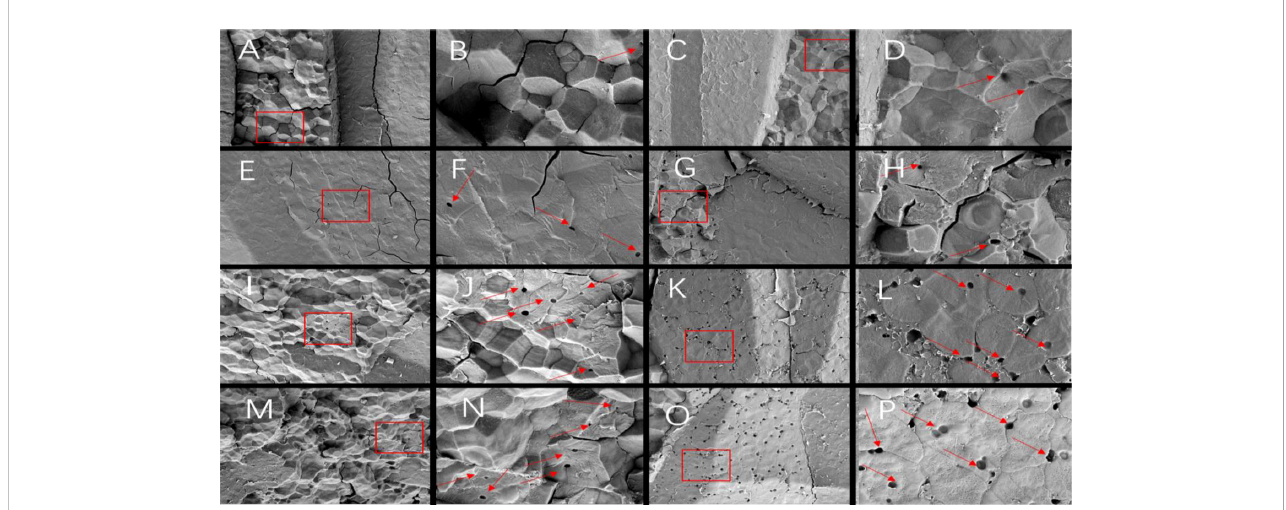
FIGURE 4 Endosperm core of (A, B) normal grains and (C, D) non-chalky grains of Y28, (E, F) normal grains and (G, H) non-chalky grains of N5718, (I, J) normal grains and (K, L) non-chalky grains of W113, (M, N) normal grains and (O, P) non-chalky grains of Y5118. A/C/E/G/I/K/M/O are at 1500x and B/D/F/H/J/ L/N/P are at 5000x. B/D/F/H/J/L/N/P are the enlarged view of red rectangle areas in A/C/E/G/I/K/M/O ,